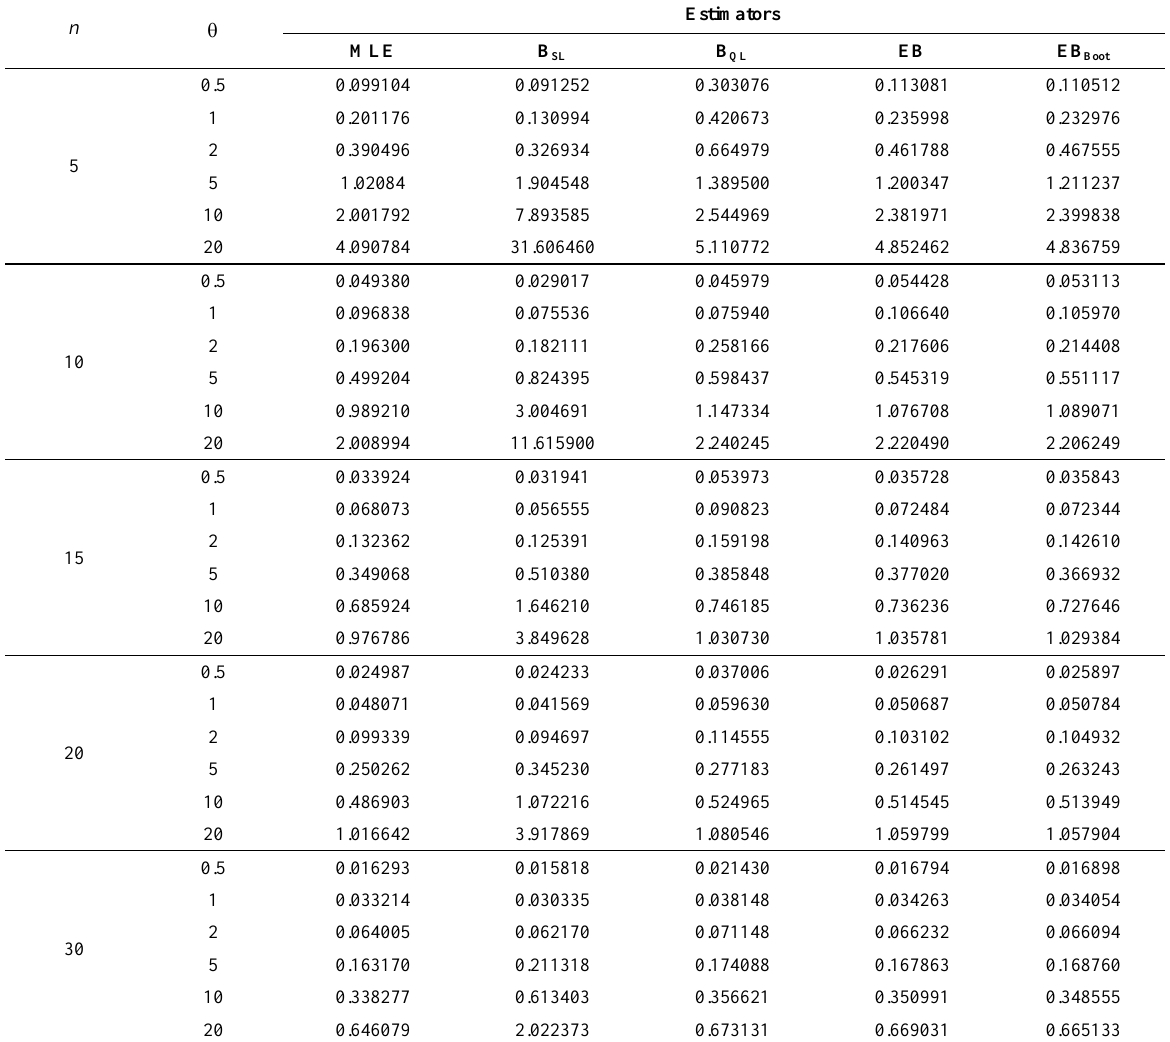
Table 1. MSE of different estimators of Poisson distribution when a =2, b